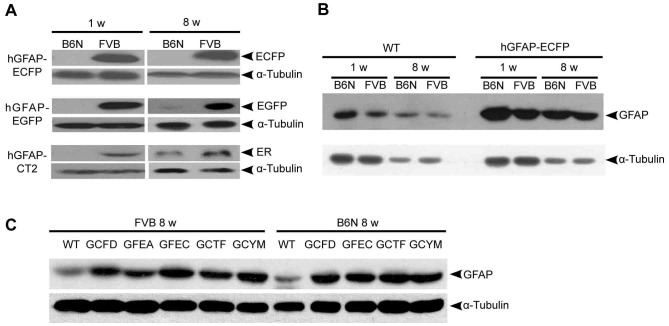
Comparative Western blot analysis of endogenous GFAP and transgenic proteins in B6N and FVB mice.Cerebellar homogenates of transgenic and wild type mice (1 w and 8 w) were probed with anti-GFP (to detect ECFP or EGFP), anti-human estrogen receptor α (ER α, recognizing CT2), and anti-GFAP and anti-α-tubulin antibodies. (A) Western blot analysis of transgene expression. (B) Western blot analysis of endogenous GFAP expression in WT and transgenic mice (hGFAP-ECFP)GCFD. (C) Western blot analysis of endogenous GFAP expression in WT and five transgenic mouse lines (hGFAP-ECFPGCFD; hGFAP-EGFPGFEA; hGFAP-EGFPGFEC; hGFAP-CT2GCTF; hGFAP-AmCyanGCYM) in both FVB and B6N background.